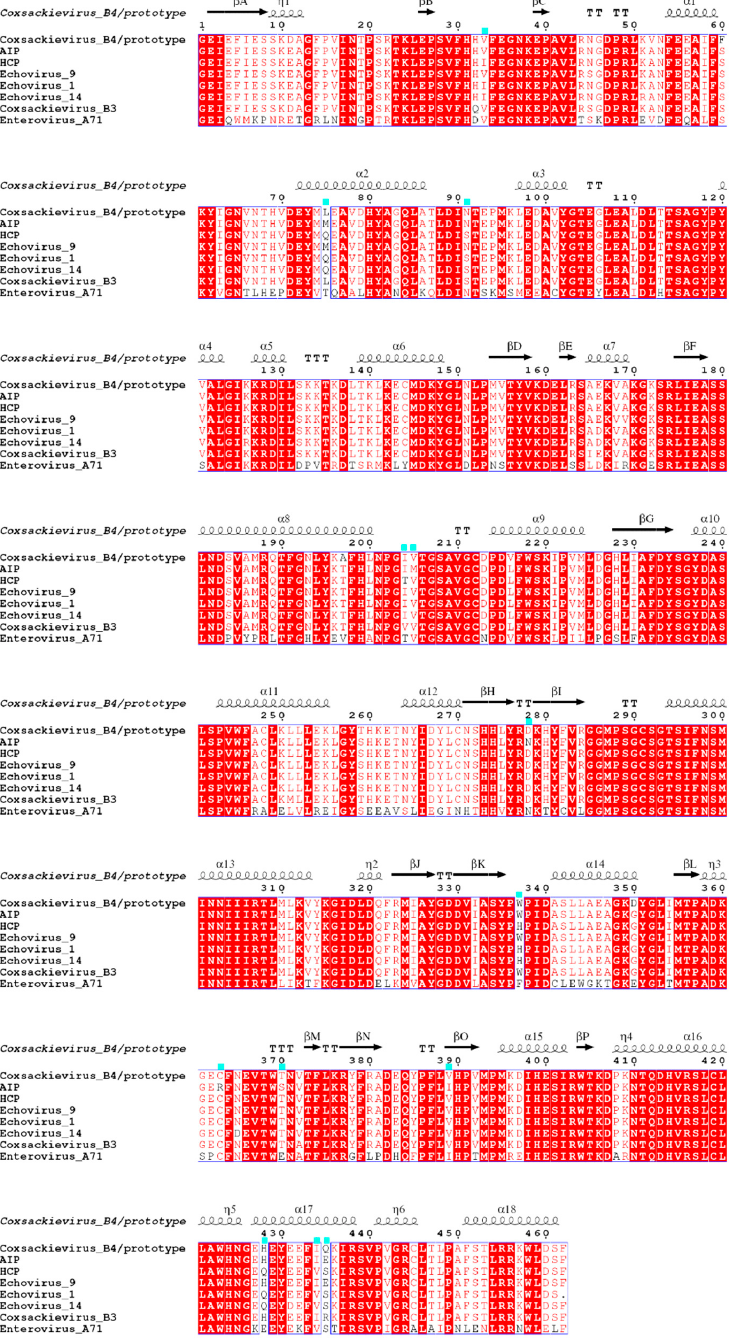
Figure 4. Sequence alignment of CVB4 RNA-dependent RNA polymerase. The enteroviruses involved in the analysis included prototype strains of CVB4, CVB4 isolated from AIP, and HCP groups, E1, E9, E14, CVB3 and EV-A71. The secondary structural elements of CVB4 RdRp ( 3D pol ) are marked at the top of the alignment; curves and arrows represent α -helices and β -strands, respectively. The number of residues at the top refer to the RdRp ( 3D pol ) sequence of the CVB4 prototype strain, and cyan square markers represent amino acid sites that differ between AIP and HCP